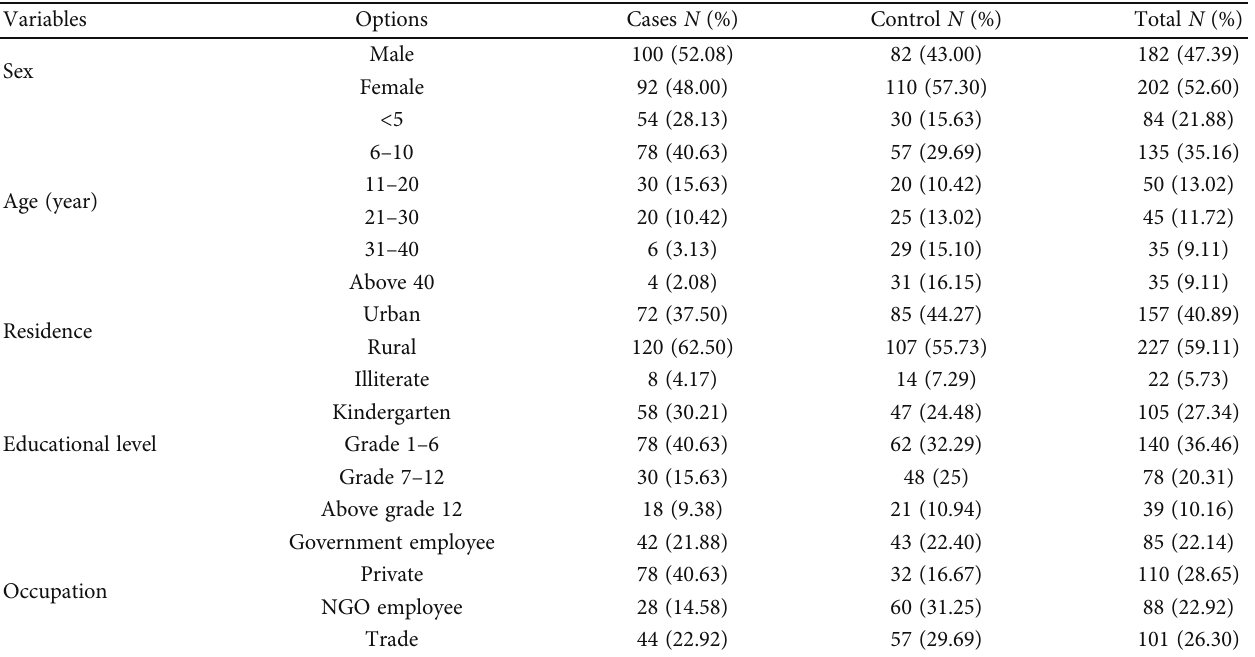
Table 1: Socio-demographic distribution of cases ( N = 192 ) and controls ( N = 192 ) in a study of intestinal protozoal parasitic infections among patients visiting Negelle Borena General Hospital.